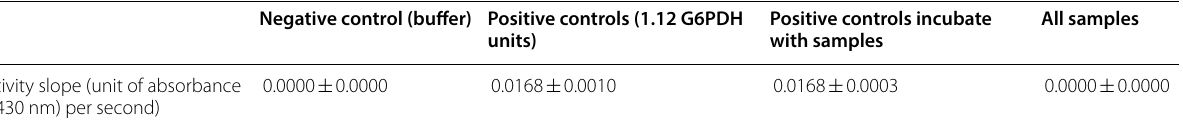
Table 3 Cell lysis detection assays Negative control (buffer) Positive controls (1.12 G6PDH Positive controls incubate units) with samples Activity slope (unit of absorbance (430 nm) per Positive controls contained 1.12 units of glucose-6-phosphate dehydrogenase (G6PDH) in buffer. Positive controls incubated with cells samples were to test inhibitors presence in samples